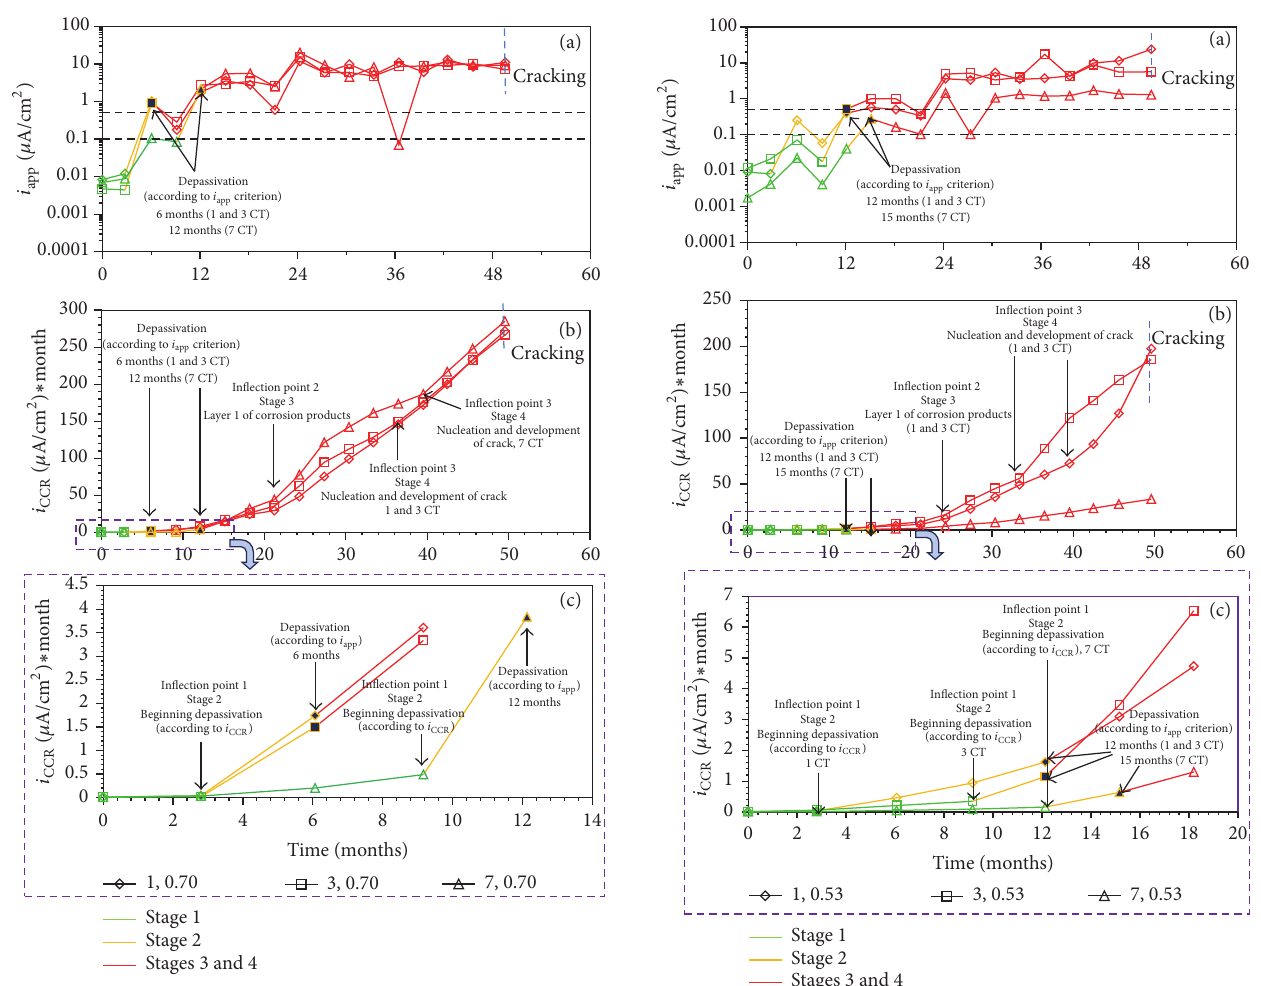
𝑖 𝑖 app and (b and c) CCR versus exposure time, w/c ratio = 0.53, and three